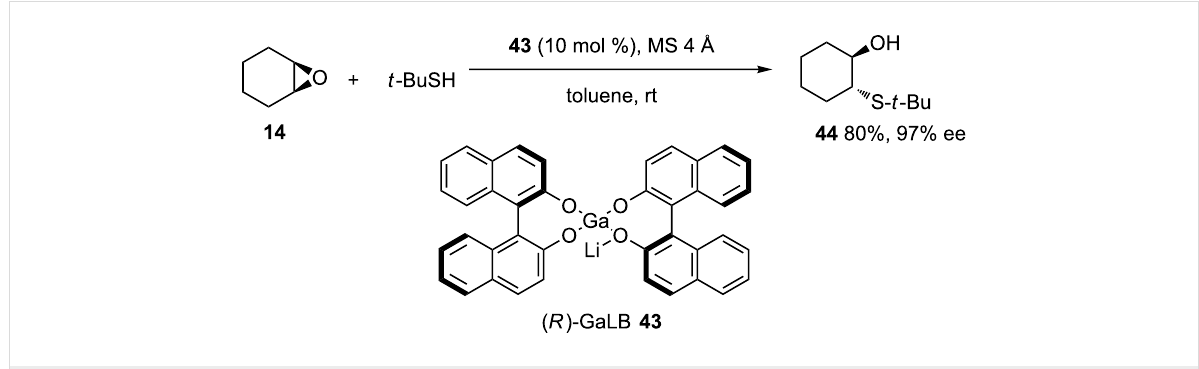
Scheme 12: Catalytic asymmetric ring opening of symmetrical epoxides with t -BuSH catalyzed by ( R )-GaLB ( 43 ) with MS 4 Å.